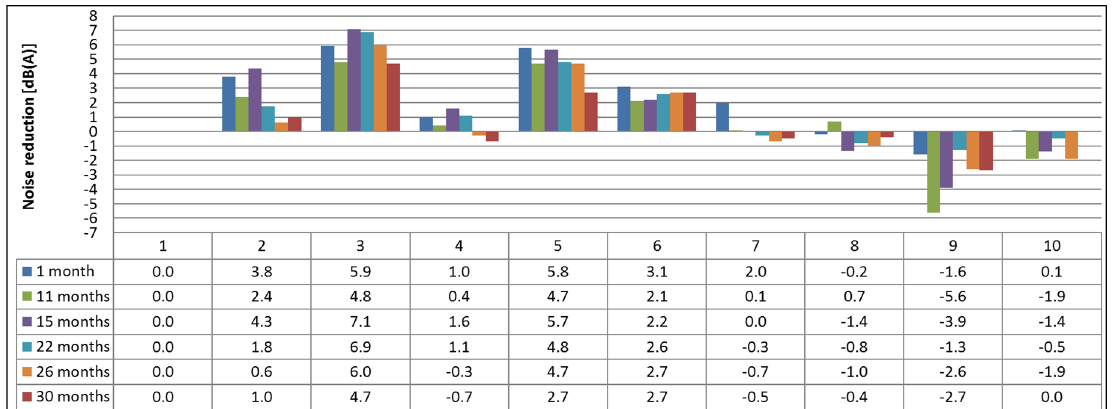
Figure 3. Overview of SPB results ( L veh , cars ) 1, 11, 15, 22, 26 and 30 months after construction (with temperature correction) including 95% confidence intervals. The reference speed is 80 km/h.